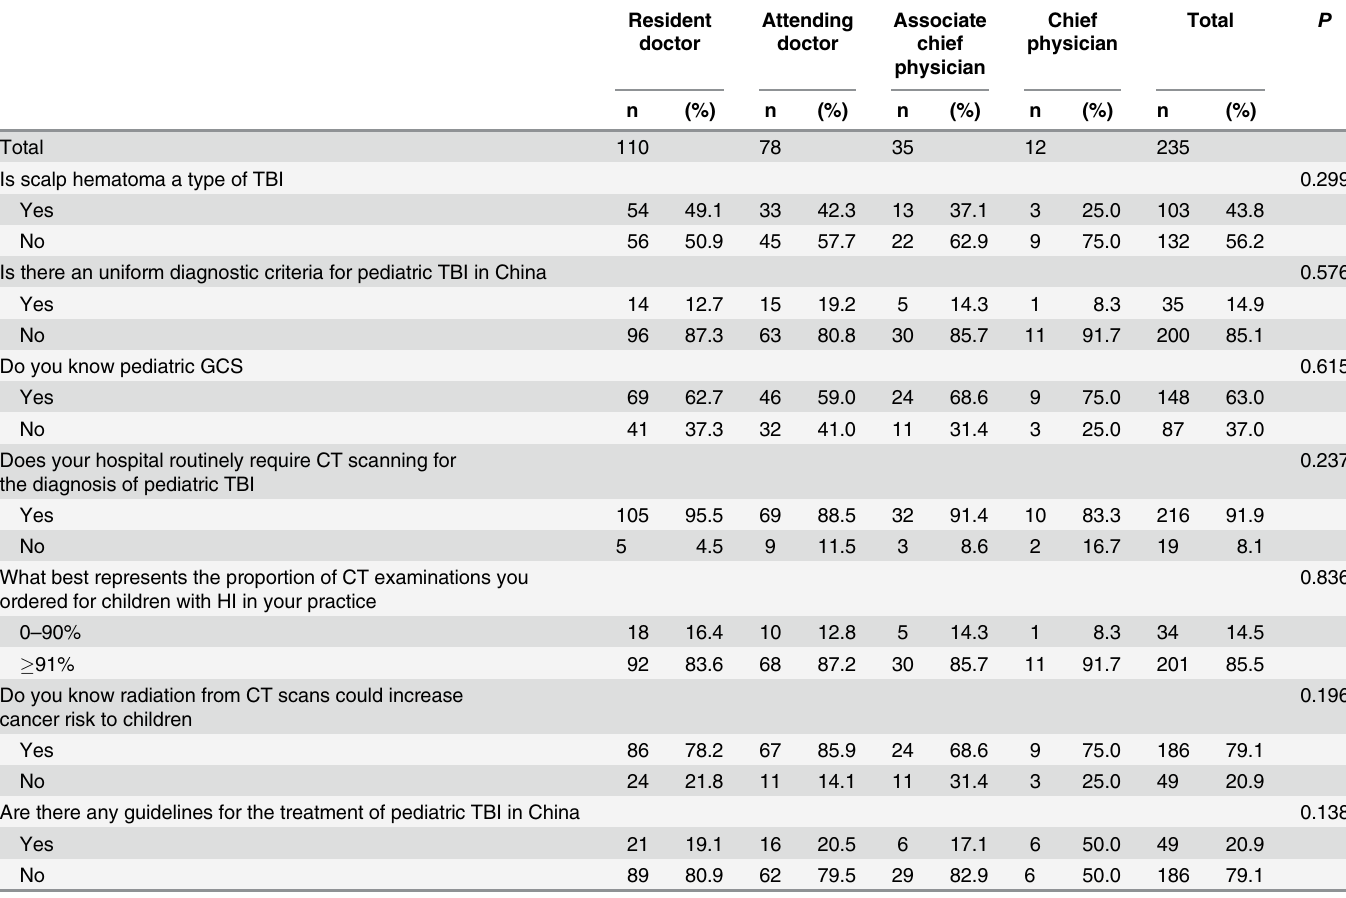
Table 3. Clinicians' Knowledge and Experiences of Pediatric TBI from 9 Large Hospitals in China Stratified by Doctor ’ s Title.